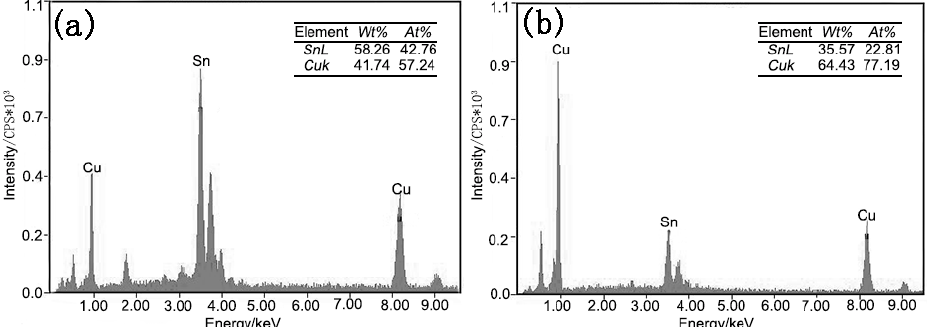
Figure 2. Cross-section micrographs of the interfacial IMC aged for different time and temperature.